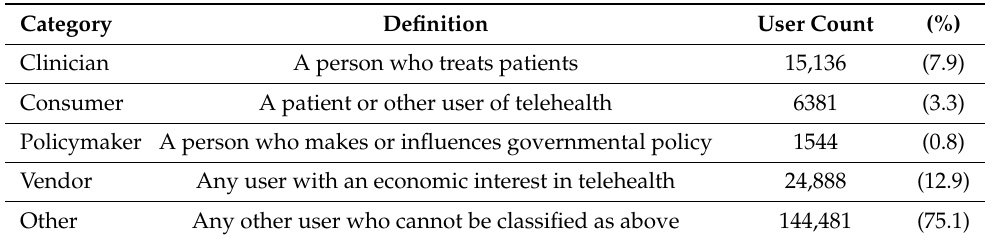
Table 2. Distribution of tweets by user type.